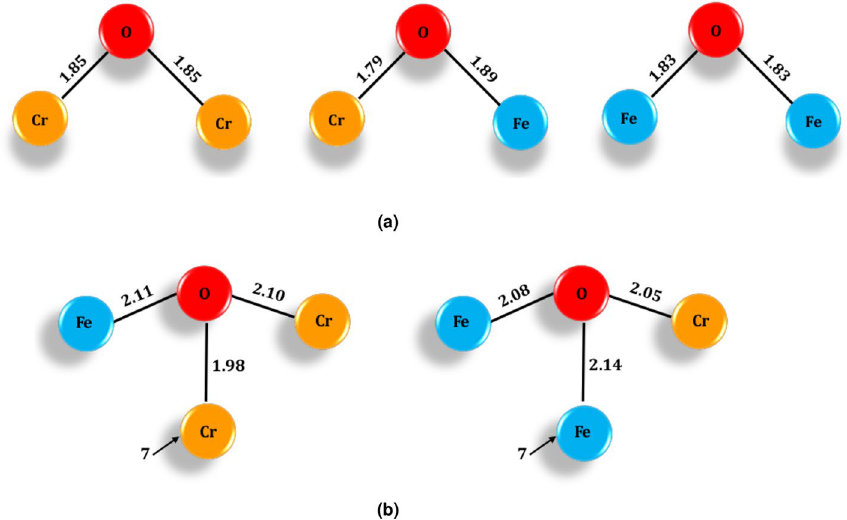
Figure 2. Schematic figure of the distances (in Å) between an adsorbed oxygen atom and the nearest metal atoms. Upper panel: Oxygen atom adsorbed to the bridge site atoms, at atomic sites 1 and 4 (see Fig. 1 for the numbering of the sites). Lower panel: Oxygen atom at the hollow site, the Fe and Cr atoms on the side of the oxygen are atoms at sites 1 and